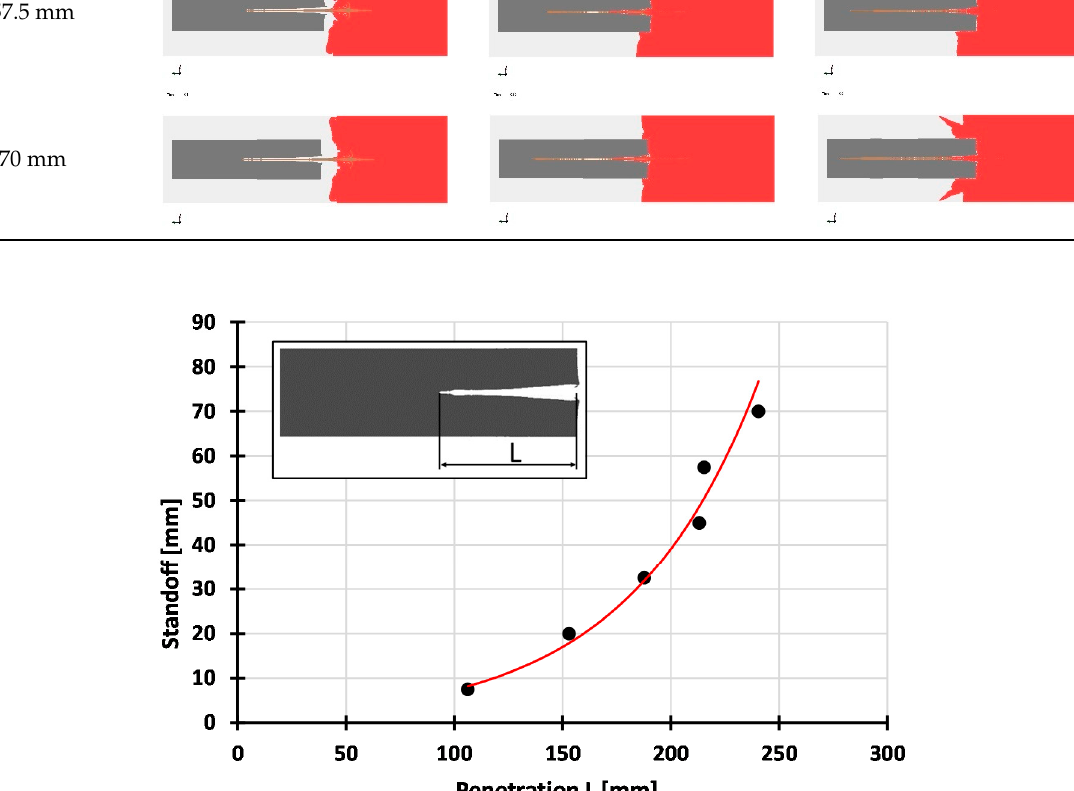
Figure 5. Characteristics of the change of penetration depth of the shaped charge in the steel block depending on the distance from the target. Depending on the distance between the charge and the target, the value of the veloc- ity of the cumulative stream front changes. For the charge in question, the value of the maximum speed at the time of formation of the cumulative stream was 7180 m/s. Figure 6 shows the view of the cumulative flux with a map of the resultant velocity value at the moment of contact between the flux front and the target. ( a ) ( b )